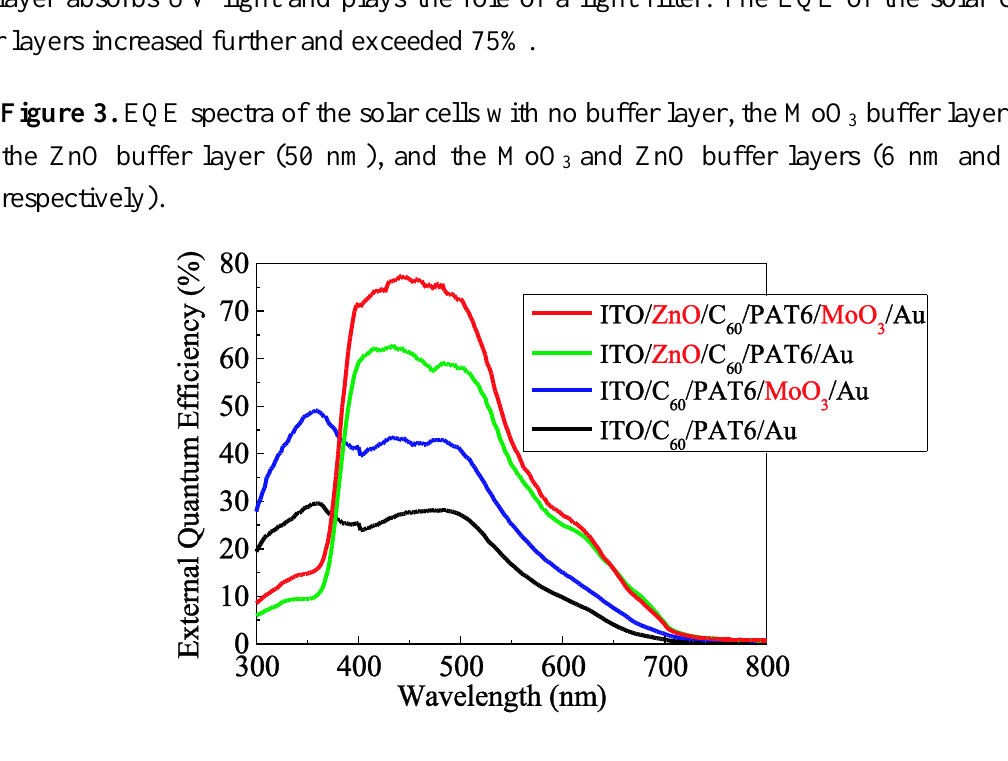
buffer layer (6 nm), 3